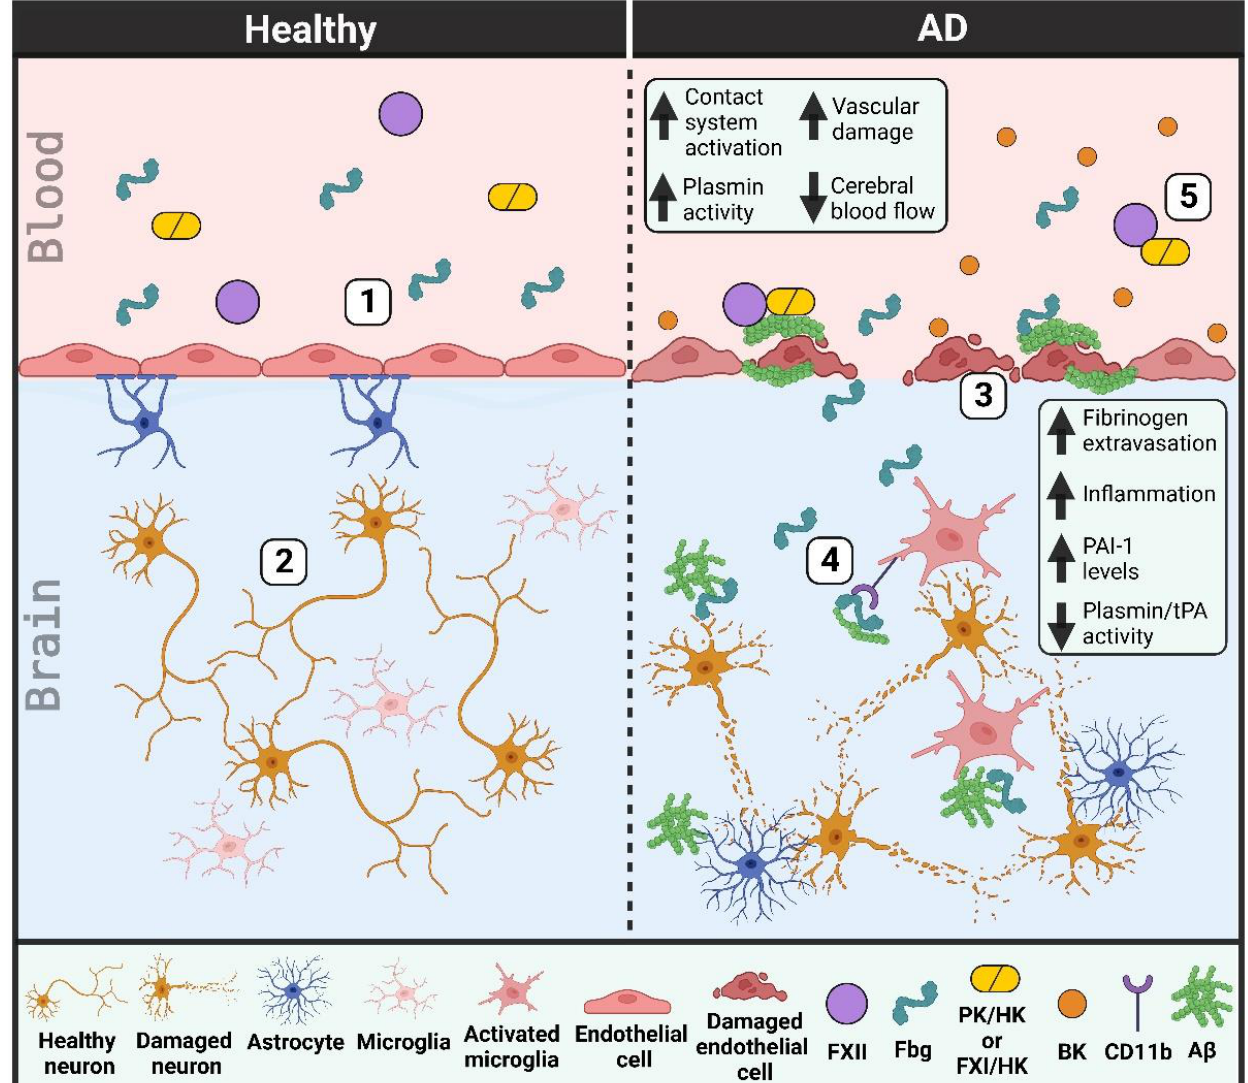
Figure 1. Vascular dysfunction in Alzheimer’s disease (AD) patient brains and blood vessels. (1) Healthy individuals have an intact blood-brain barrier. Endothelial cells are connected by tight junc- tions and lined by pericytes (not shown) and astrocytes. (2) This intact blood-brain barrier prevents the extravasation of blood proteins into the brain parenchyma, thereby helping to limit neuroin- flammation and protect neurons from damage. (3) The blood-brain barrier in AD patients is dam- aged as tight junctions are lost and endothelial cells and pericytes (not depicted) degenerate. Cere- bral blood flow is decreased due in part to an increase in beta-amyloid ( Aβ ) along blood vessel walls (cerebral amyloid angiopathy). (4) This vascular damage allows for the extravasation of blood pro- teins, like fibrinogen (Fbg), into the brain parenchyma. Fibrinogen may promote neuronal degener- ation and induce an immune response in the brain, both through its interaction with Aβ and its binding to and activation of the CD11b/Mac-1 receptor on microglia. tPA and plasmin activities are decreased while PAI-1 levels are increase d, limiting the removal of Aβ plaques from the brain pa- renchyma. (5) There is increased plasma contact system activation in AD patient blood due to en- hanced interaction of plasma Aβ with factor XII (FXII). Bradykinin (BK) levels are increased, pro- moting neuroinflammation and further vascular damage. (PK, plasma kallikrein; FXI, factor XI; HK, high molecular weight kininogen).